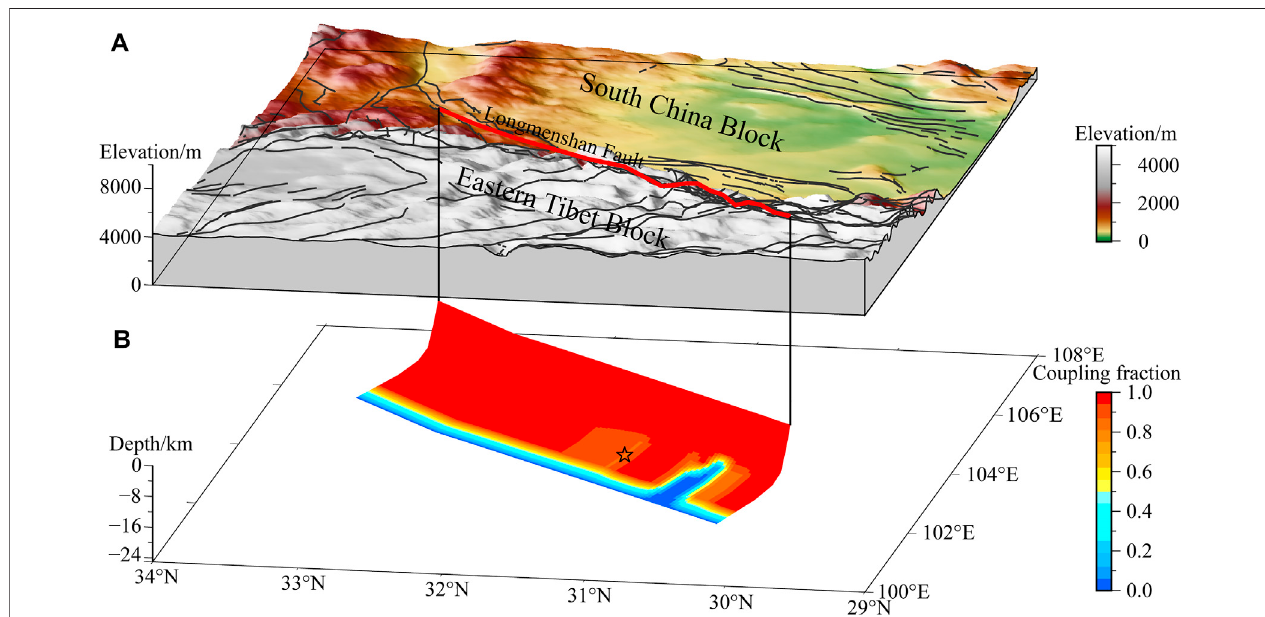
FIGURE2 |(A) Topographicmap ofthe area around the Longmenshan fault zone (LFZ) and (B) spatial distribution of thecoupling fraction during 1999 – 2007. The thinblacklinesin (A) denotethefaults,andthethickredlinedenotesthesurfacetraceoftheLFZ.Theblackstarin (B) denotestheWenchuanearthquakesourcelocation (Liu et al., 2008).